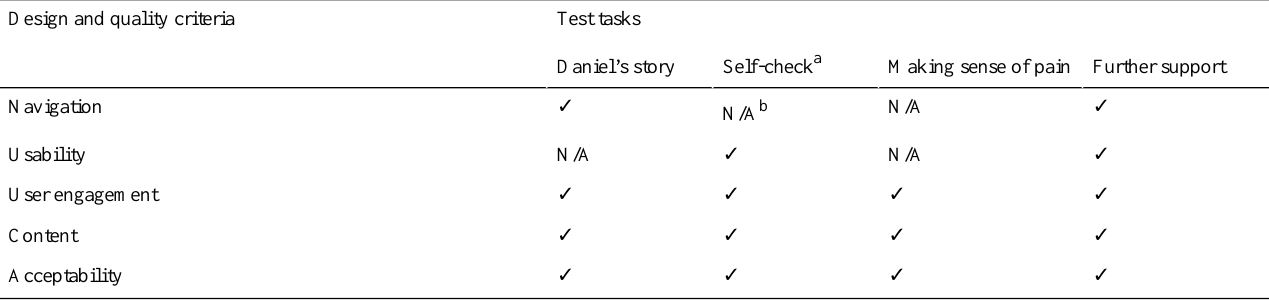
Table 1. Four test tasks were mapped, as per ticks, to reflect specific electronic health evaluation criteria.